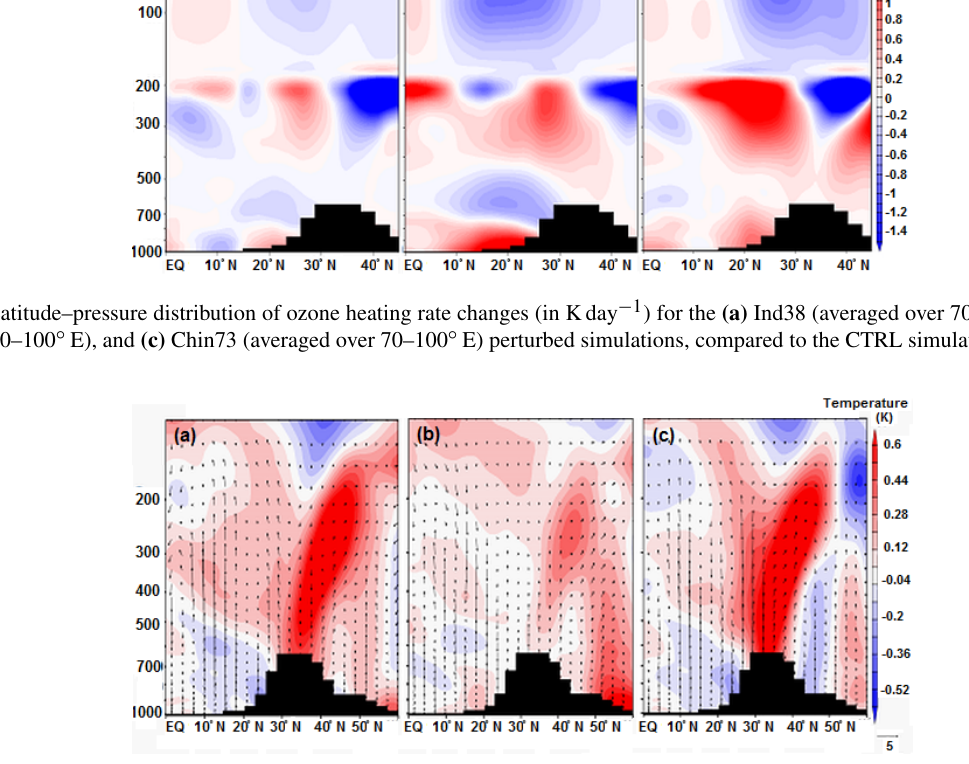
Figure 8. Latitude–pressure cross section of temperature anomalies (K) averaged for the monsoon season (June–September) and over 70– 100 ◦ E obtained from (a) Ind38-CTRL, (b) Ind73-CTRL, and (c) Chin73-CTRL simulations. Black arrows indicate wind vectors (the vertical velocity field has been scaled by